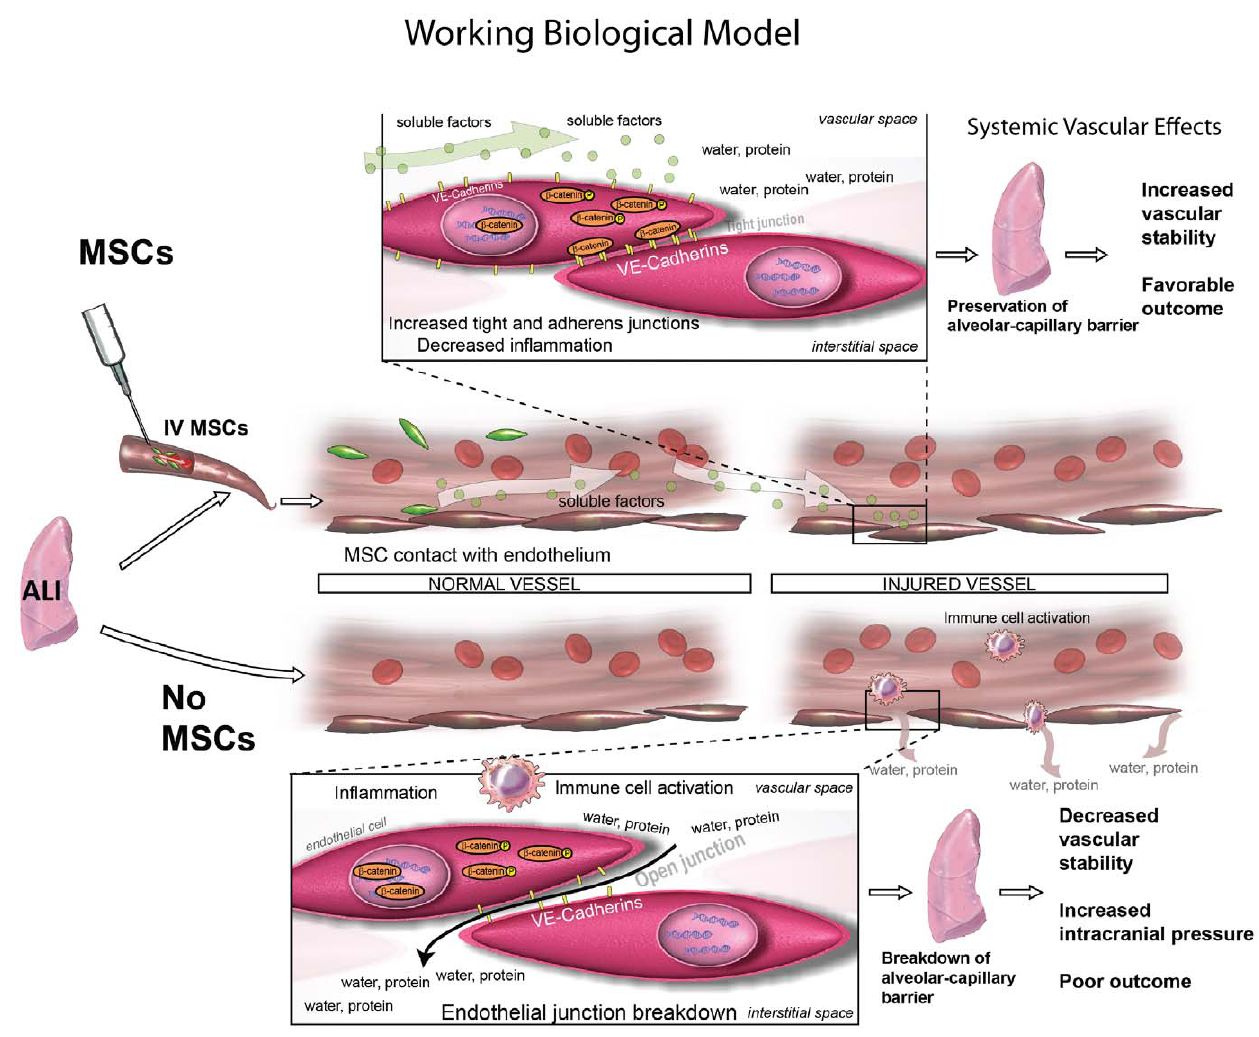
Figure 7. Soluble factors play a role in the effects of IV MSCs in vivo. Figure 7 shows a working biological model of how MSCs may function biologically when delivered IV after HS. MSC attach to pulmonary vascular endothelial cells in the lungs where they produce soluble factor(s) that affect vascular stability in the lungs through modulation of AJs, TJs and checking inflammation. We hypothesize that the soluble factor(s) produced promote local and systemic vascular